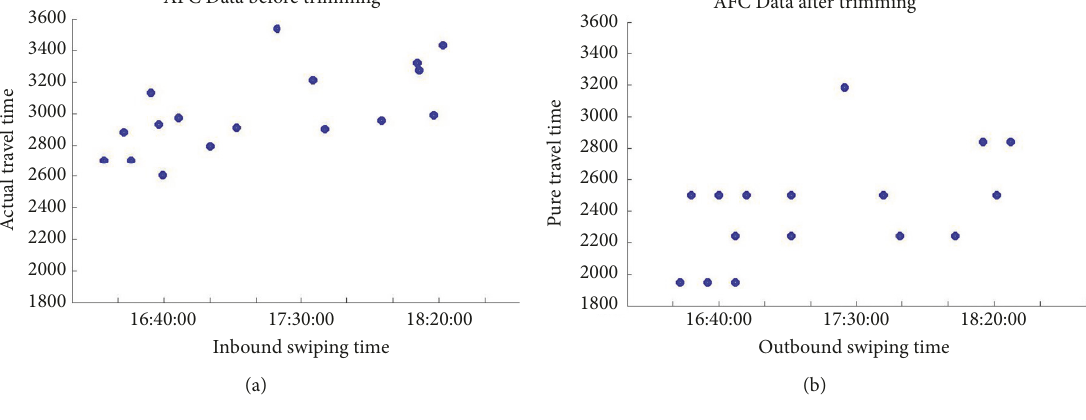
Figure 3: A sample of AFC data before and after trimming.